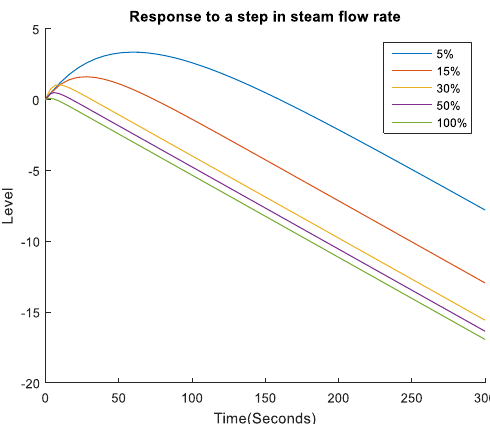
Figure 3. Responses of the water level at di ff erent operating powers (%).